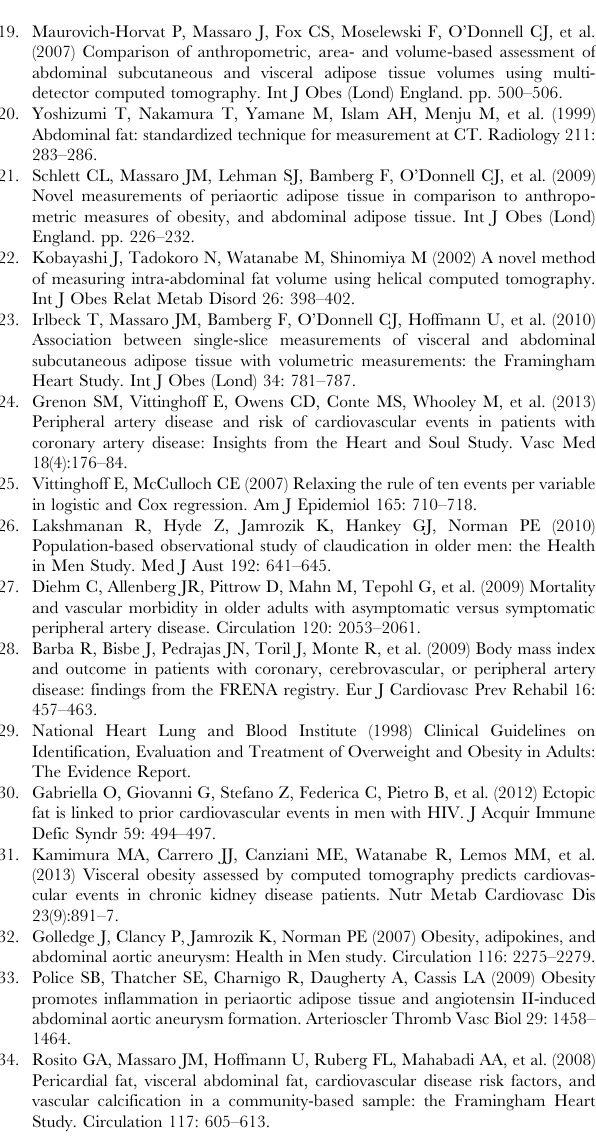
Figure S6 Kaplan Meier analysis illustrating freedom from cardiovascular events in relation to relative visceral adipose volume quartiles in patients that did not have an AAA at entry. There was no significant association between the incidence of non-fatal myocardial infarction, non- fatal stroke or death and visceral adiposity. *Cardiovascular event incidence at 3 years ( P = 0.480). Table S1 Independent determinants of non-fatal myocardial infarction in patients with PAD. Table S2 Independent determinants of non-fatal stroke in patients with PAD. Table S3 Independent determinants of cardiovascular events (myocardial infarction, stroke, death) in patients with PAD and diabetes mellitus.